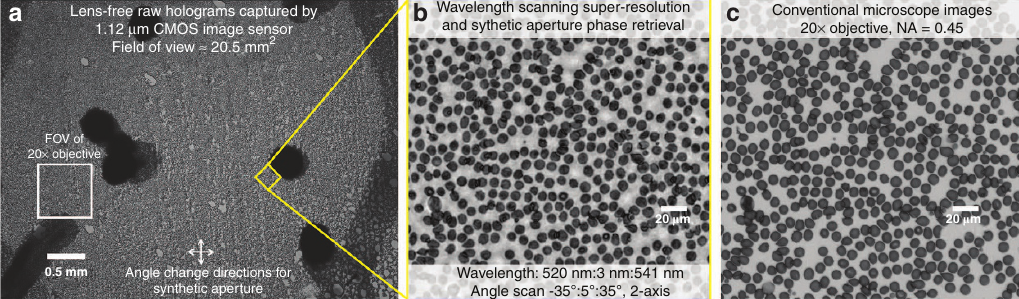
Figure 7 Lens-free imaging of a blood smear using wavelength-scanning pixel super-resolution and synthetic aperture phase retrieval. Wavelength-scanning range: 520 – 541 nm, scanning step: 3 nm. Angle scanning (two axes) range: − 35° to 35° with 5° steps. ( a ) Lens-free raw hologram captured using a CMOS image sensor with a pixel size of 1.12 μ m and a FOV of ~20.5 mm 2 . ( b ) Lens-free reconstruction of a sub-region, marked with a yellow square within the full FOV. ( c ) Conventional lens-based microscope image using a 20× objective lens (NA = 0.45).